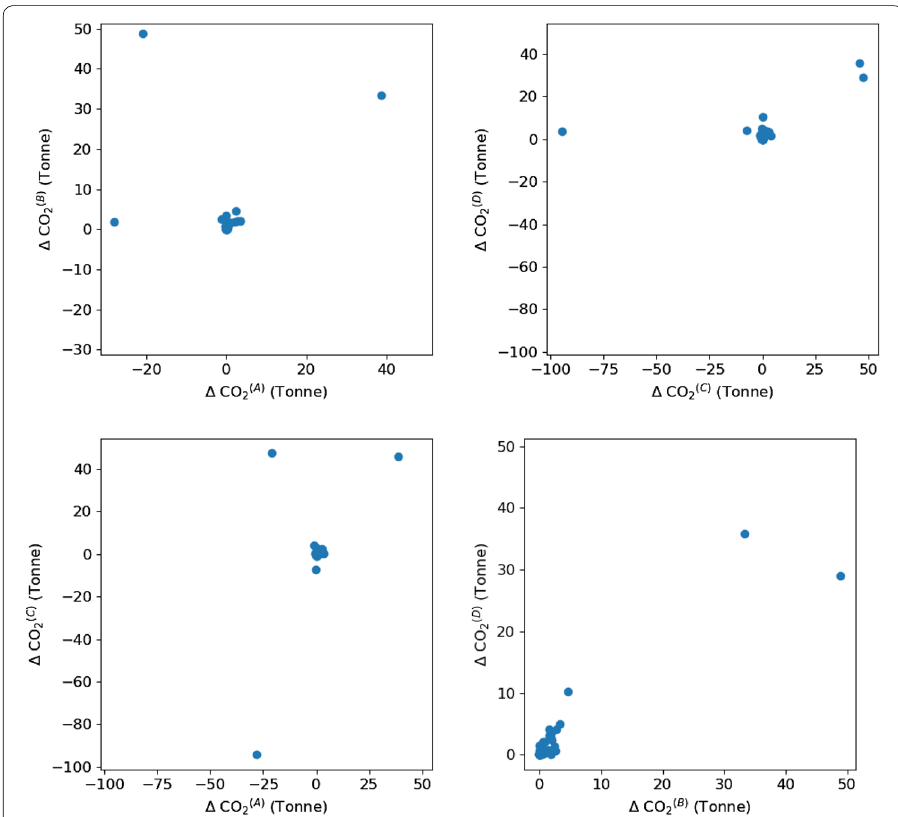
Fig. 6 Scatterplots of the change in satellite results per product or industry as a result of a change in wholesale services of 1 million Euro, using the four models (A)–(D). Each dot represents the contribution made by a particular product of sector to the total change (cid:31)